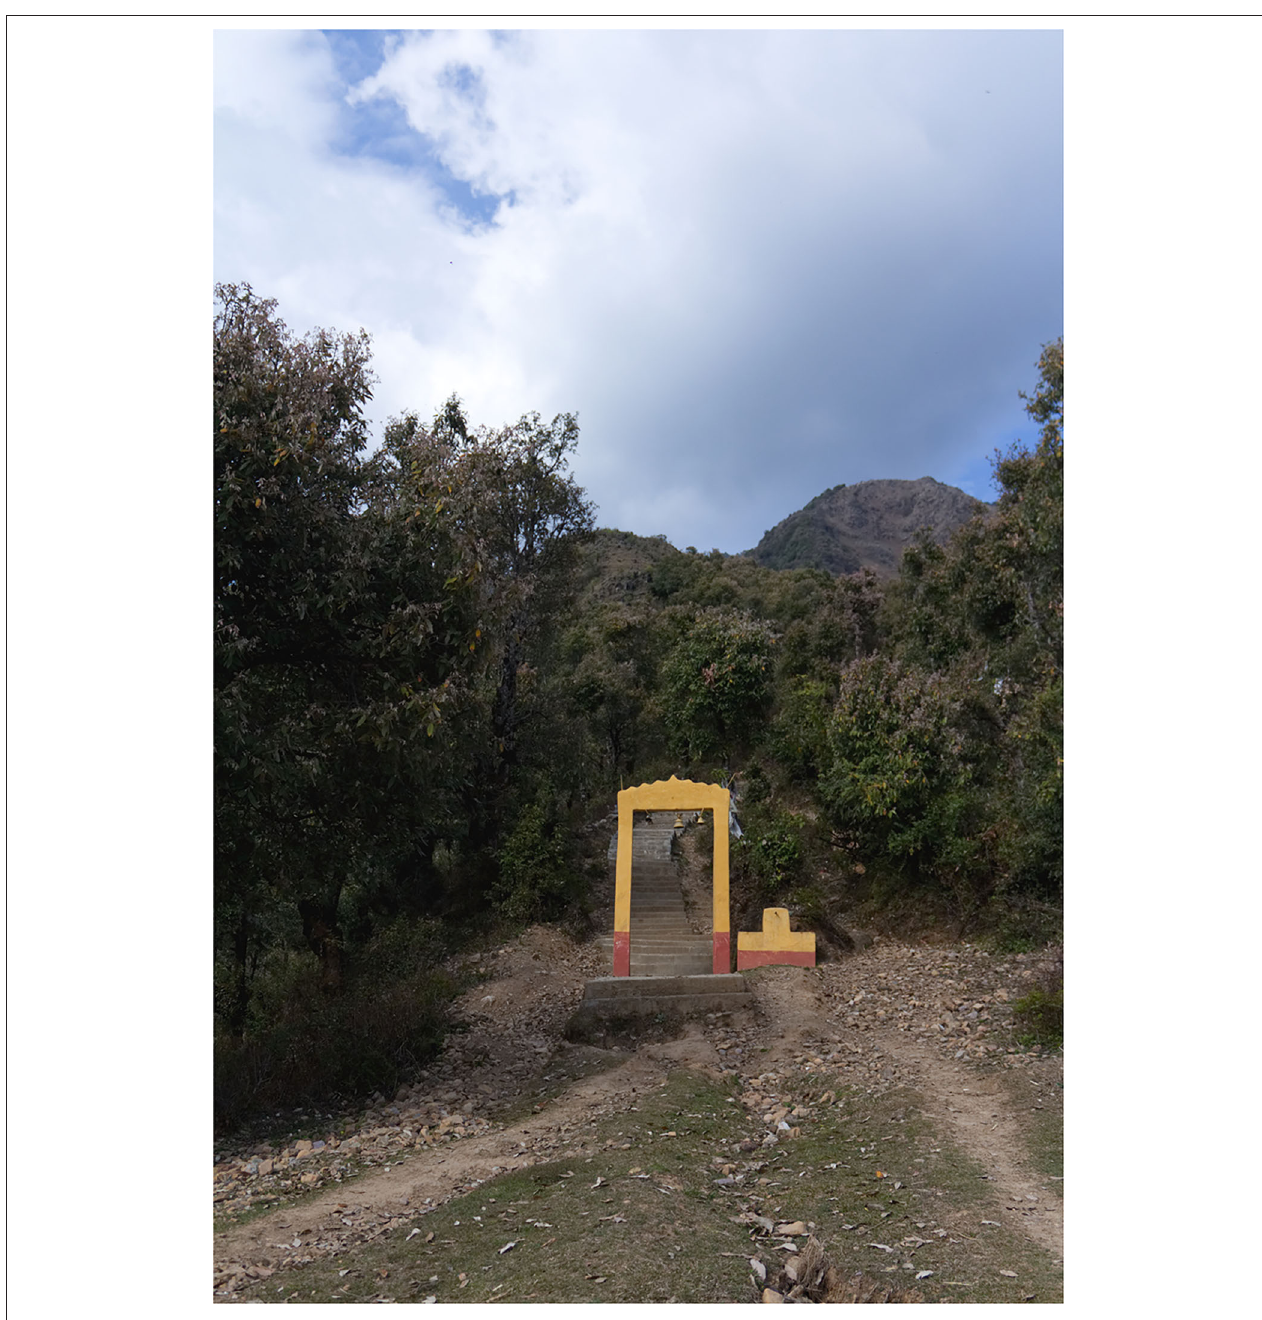
FIGURE 7 | One of the last gates before the Shikhar (ridge) of Malikarjun mountain visible